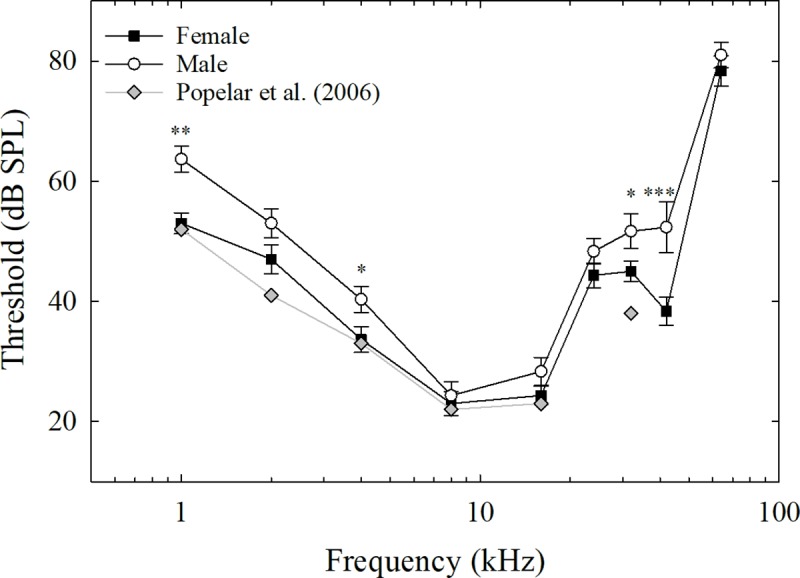
Auditory brainstem thresholds across sex.Mean ABR thresholds for males and females across all three genotypes for tones ranging from 1 to 64 kHz (error bars are standard error of the mean) compared to Popelar et al. [15] ABR thresholds from 1 month old male Long-Evans rats (Females = black squares, Males = white circles, and Popelar et al. (2006) = gray diamonds). *p < .05, **p < .01, ***p < .001.